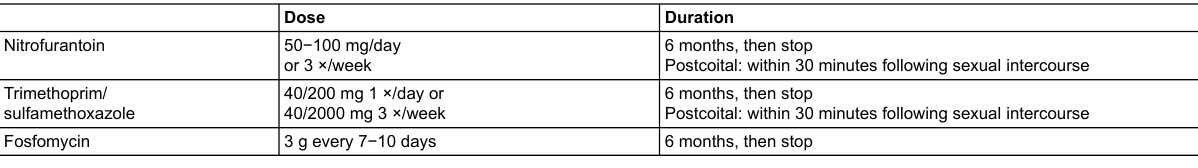
Table 6: Continuous and postcoital prophylaxis in UTIs (according UpToDate ® [61]). Dose